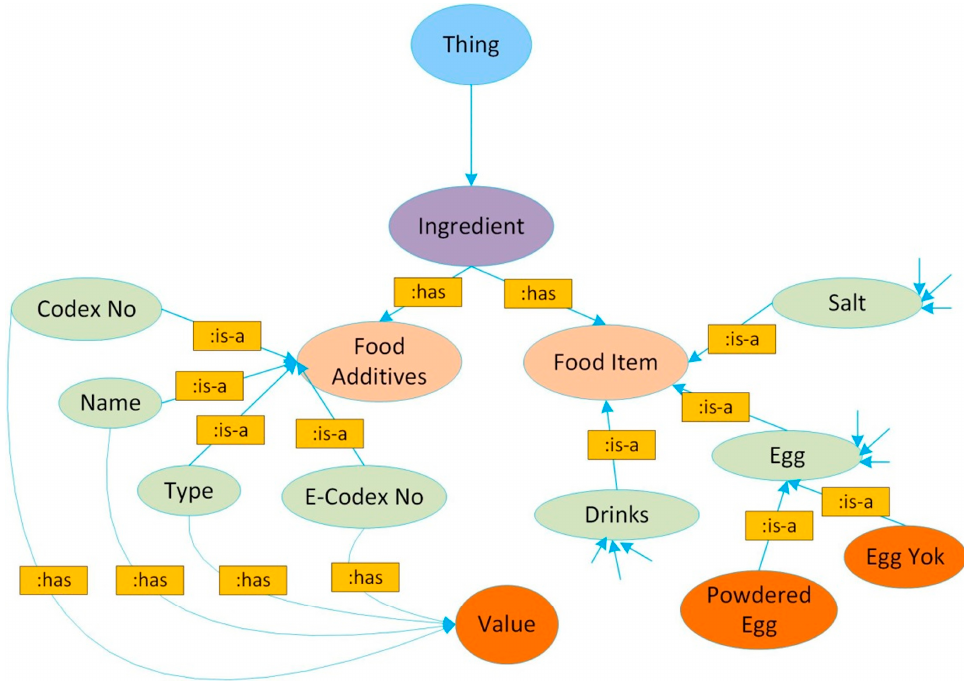
Figure 1. An example of the “Ingredient Class” of FoodWiki ontology, based on